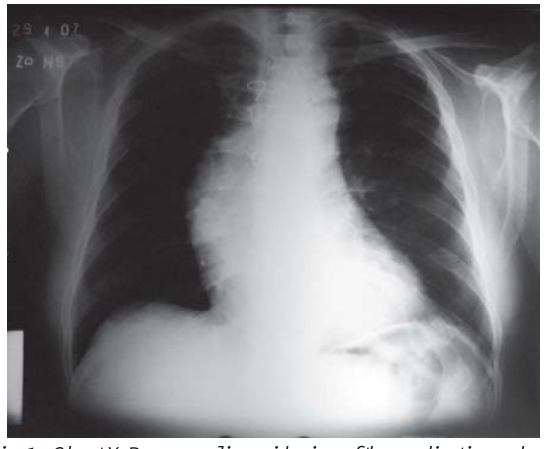
an enlarged ascending aorta